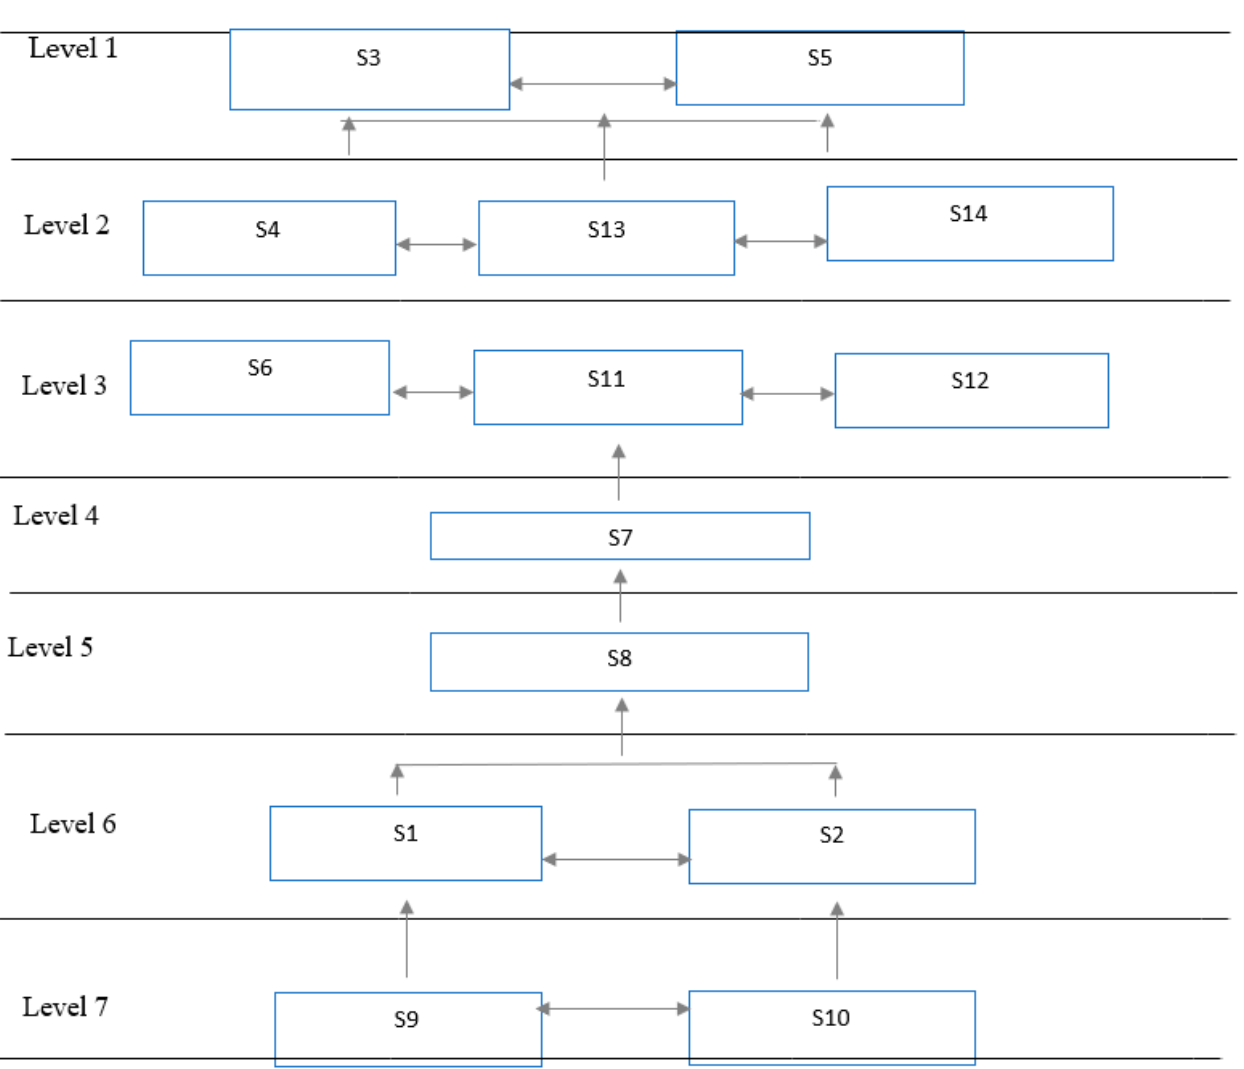
Figure 2. ISM model of key strategies for reducing socio–economic crisis during pandemic outbreak. According to the ISM model, the strategies at the bottom level are more highly significant than others.